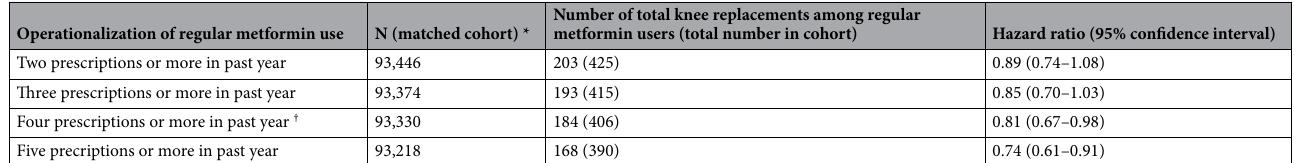
Table 2. Number of metformin prescriptions and hazard ratio on total knee replacement. *All cohorts were one-to-one matched cohorts. † Main